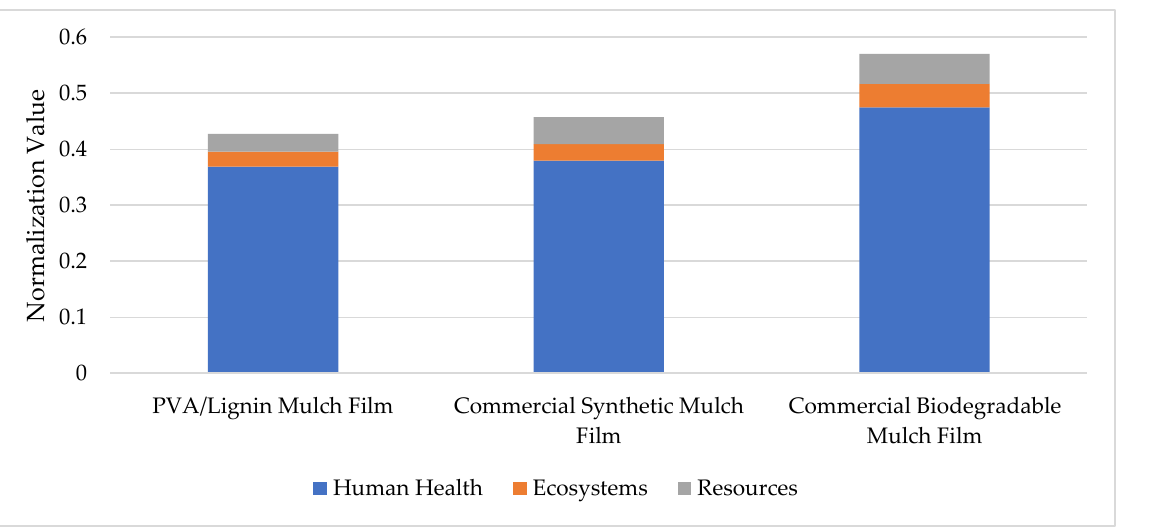
16 of 19 Figure 13. Midpoint impact categories of mulch film PVA with lignin (40PVA/60LN) compared to